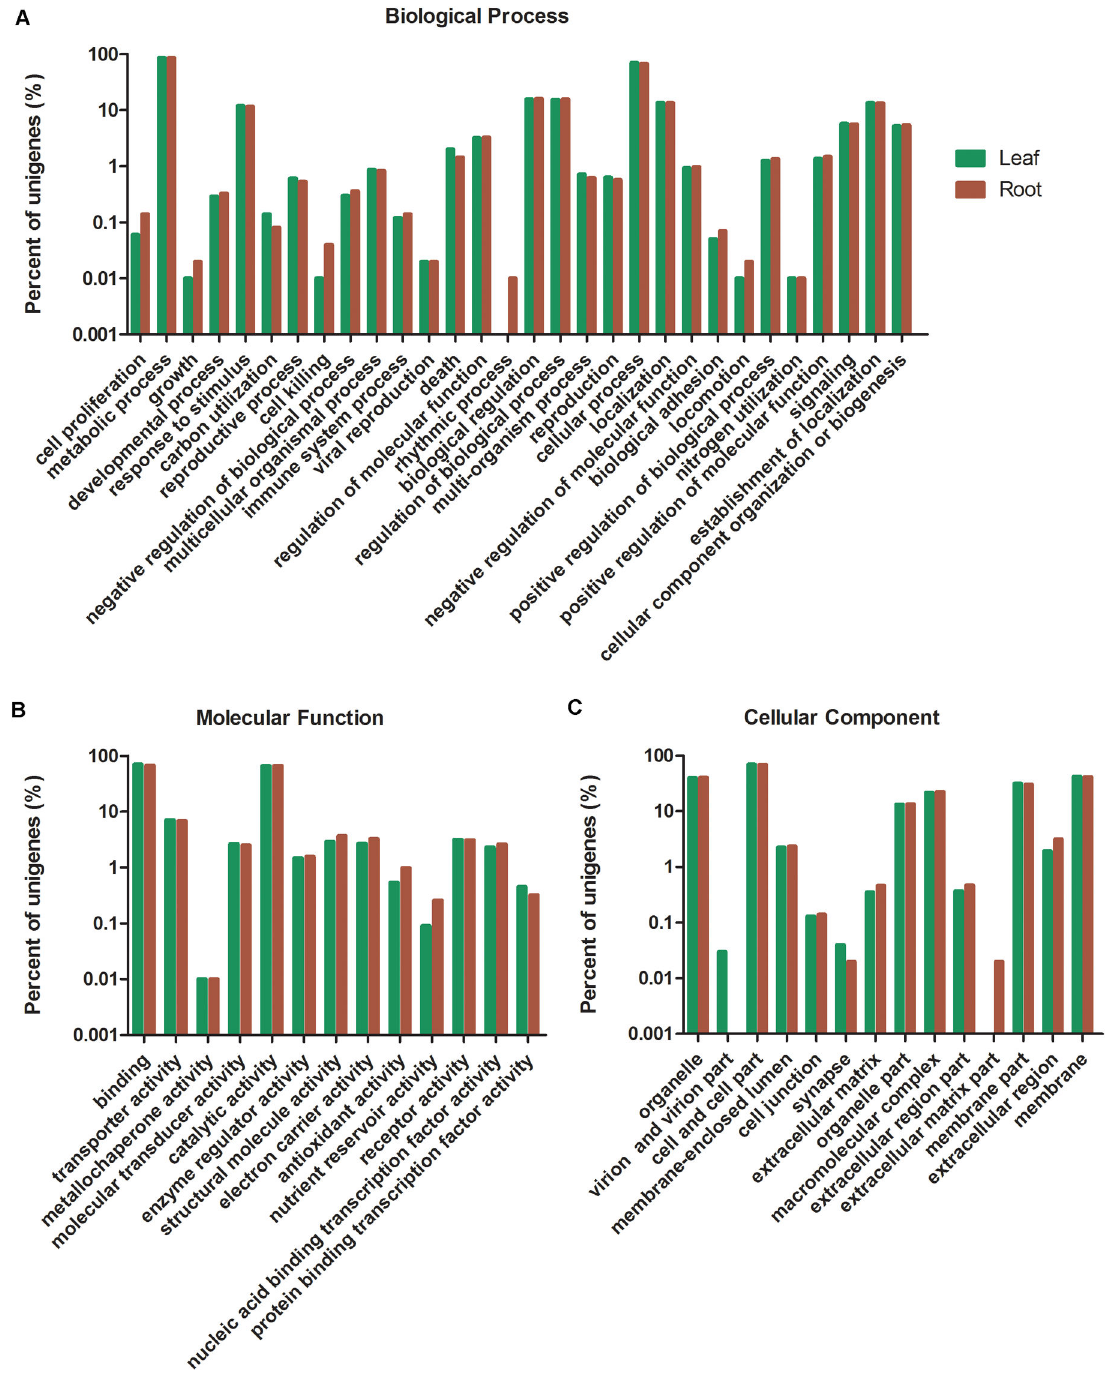
Figure 3. Functional classification of unigenes expressed in S. miltiorrhiza leaf and root. Gene Ontology (GO) terms are summarized in three main categories of biological process (A), molecular function (B) and cellular component (C).